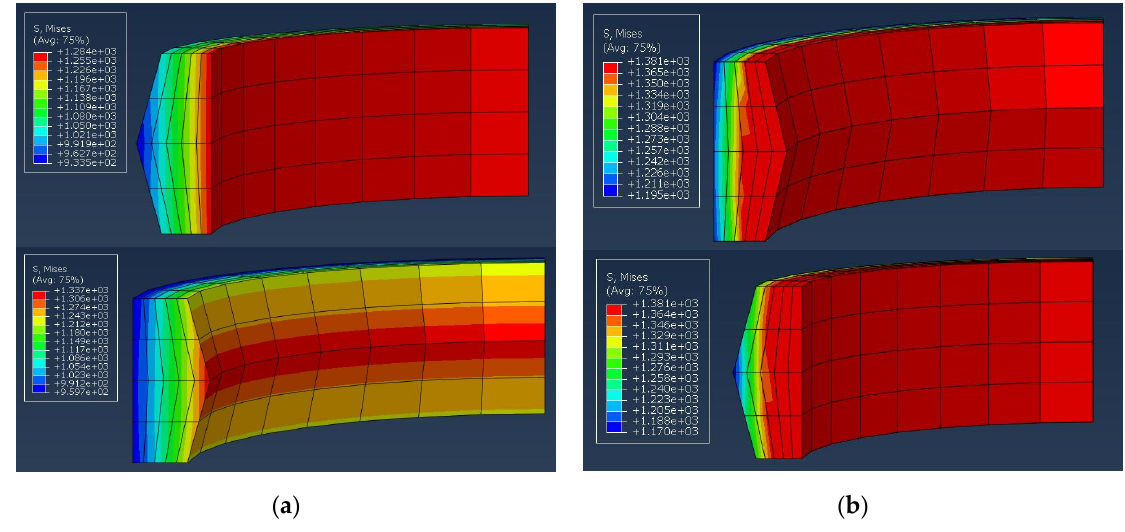
Figure 5. Mises stress contour of finite element model for different capacity limits: ( a ) 36 mm; ( b ) 48 mm.